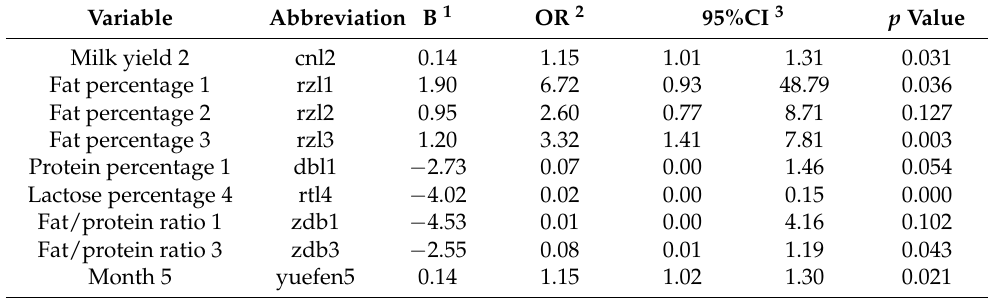
Table 8. Risk factors of mastitis.